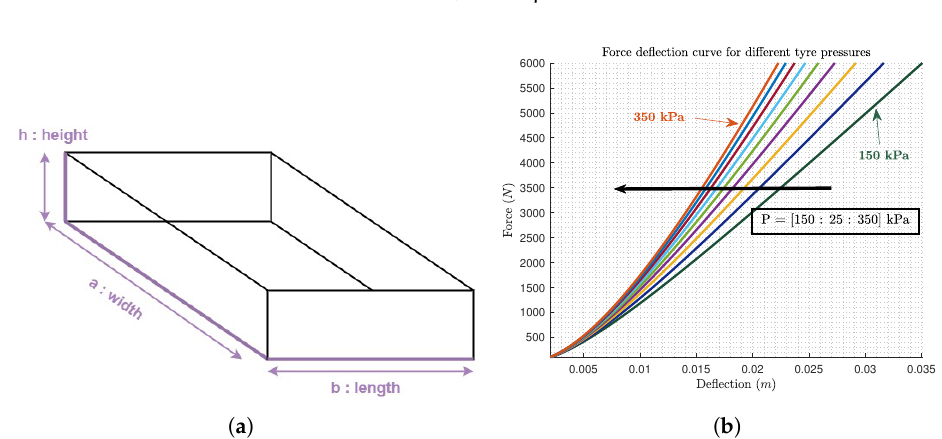
Figure 3. ( a ) The modelling of the tread element as a cuboid and ( b ) the force deflection curves according to Equation (5) for pressures ranging [150:25:350]